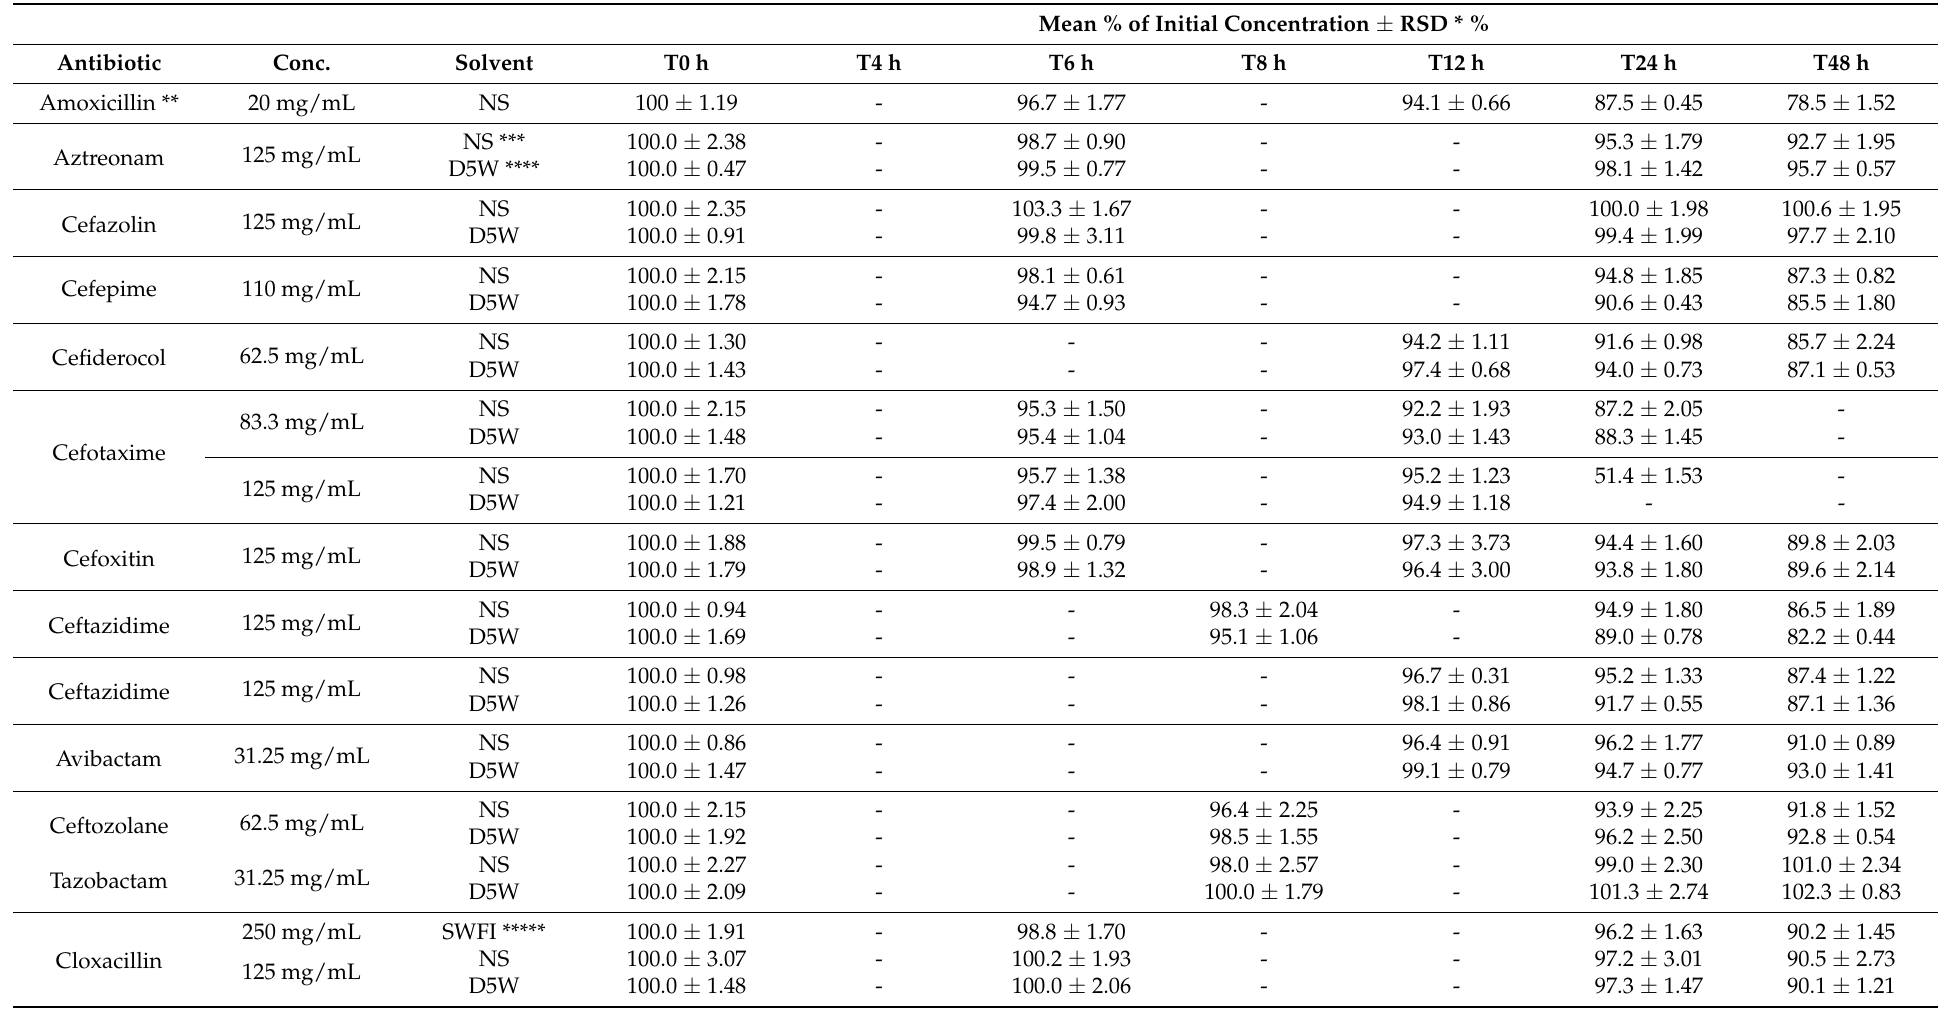
Table 2. Stability of antibiotics in polypropylene syringes and amoxicillin in polyolefin bags at 20–25 ◦ C for continuous intravenous infusion measured by